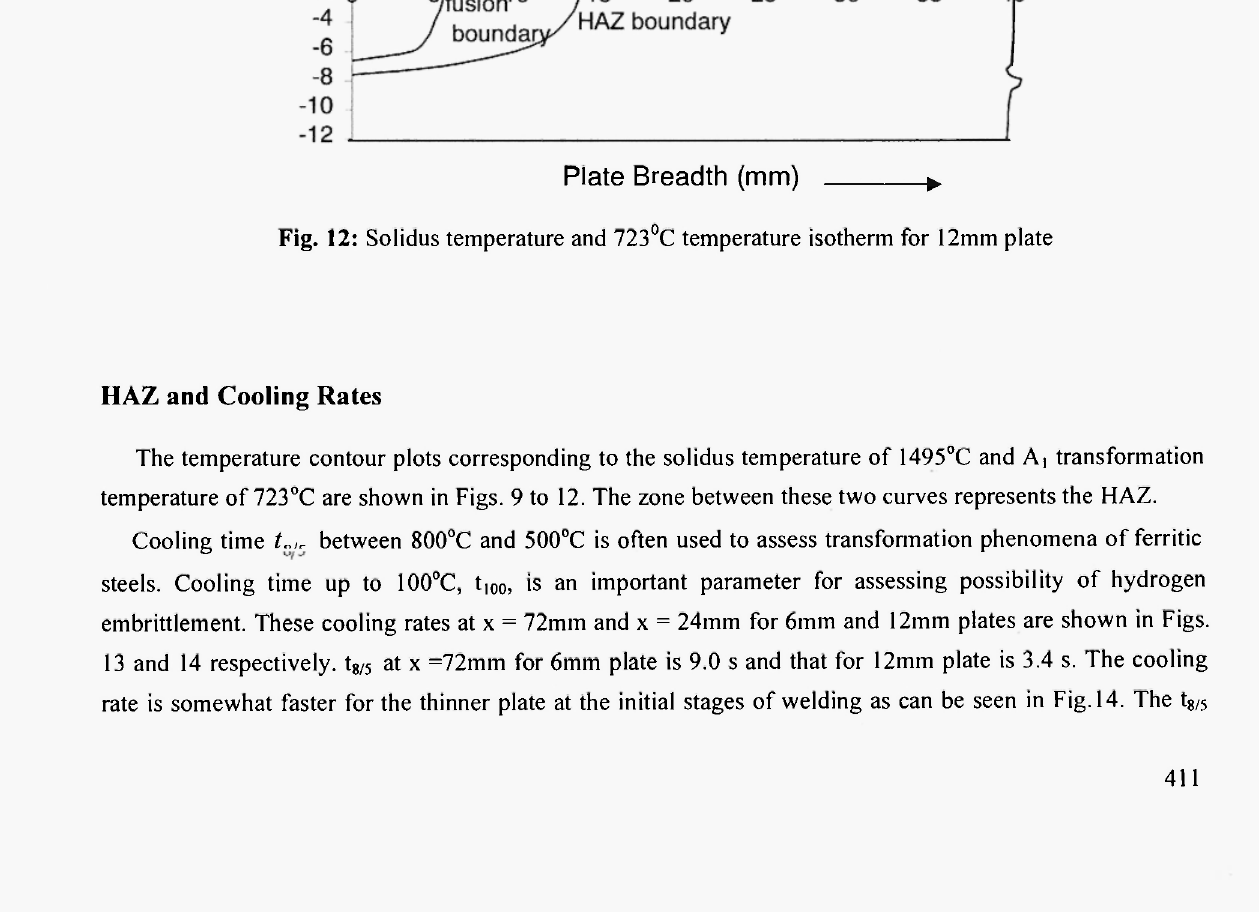
Fig. 11: Solidus temperature and 723°C temperature isotherm for 10mm plate